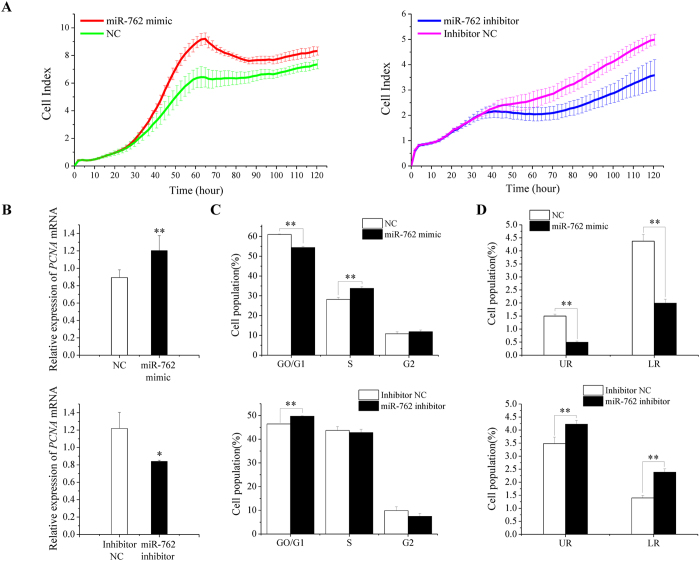
miR-762 promotes ST cell proliferation and inhibits apoptosis.ST cells were transfected with the miR-762 mimic or NC and the miR-762 inhibitor or inhibitor NC. (A) Cell growth dynamics were continuously monitored by the xCELLigence system. (B) The mRNA levels of PCNA (a marker gene for cell proliferation) were detected in ST cells 24 h after transfection. (C) Cell cycle phase was analysed 48 h after transfection by propidium iodide flow cytometry. (D) Cell apoptosis was measured 48 h after transfection using Annexin-V/PI staining, followed by flow cytometer analysis. UR: late apoptosis, LR: early apoptosis. **P < 0.01, *P < 0.05.